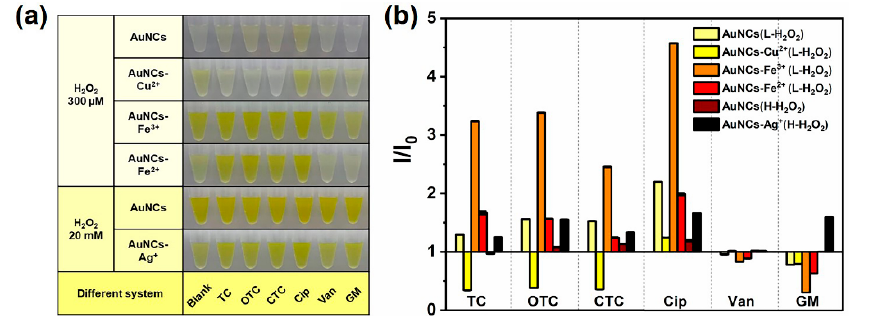
Figure 2. ( a ) Color changes of 6 antibiotics in different AuNCs-metal ions reaction systems under visible light. ( b ) The absorbance response at 452 nm ( I/I 0 ) of sensor array against various antibiotics. Reaction conditions: AuNCs, 0.5 mg mL − 1 ; Cu 2+ , Fe 3+ , Fe 2+ , 5 μ M; Ag + , 10 μ M; antibiotics, 15 μ M; H 2 O 2 , 300 μ M (L-H 2 O 2 ); TMB, 0.1 mg mL − 1 and 20 mM (H-H 2 O 2 ).